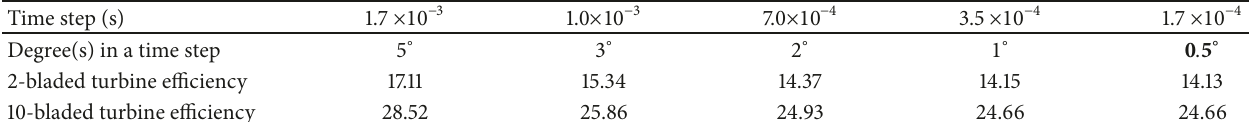
Table 4: Time step reduction effect on simulation.